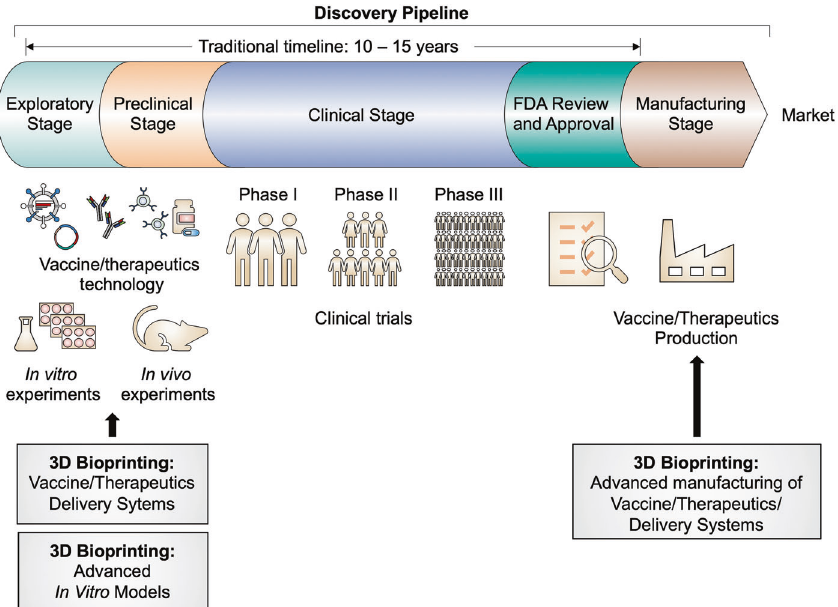
Fig. 1 Schematic drawing of the traditional vaccine/therapeutics discovery pipeline and the possibilities of retooling with 3D bioprinting technologies (gray